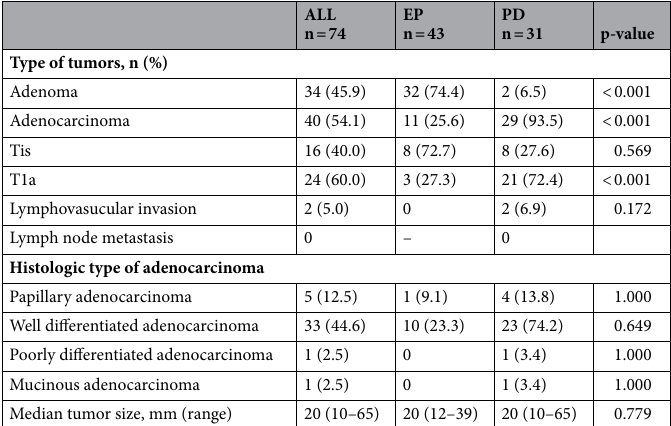
Table 4. Pathological findings. EP endoscopic papillectomy, PD pancreatoduodenectomy.